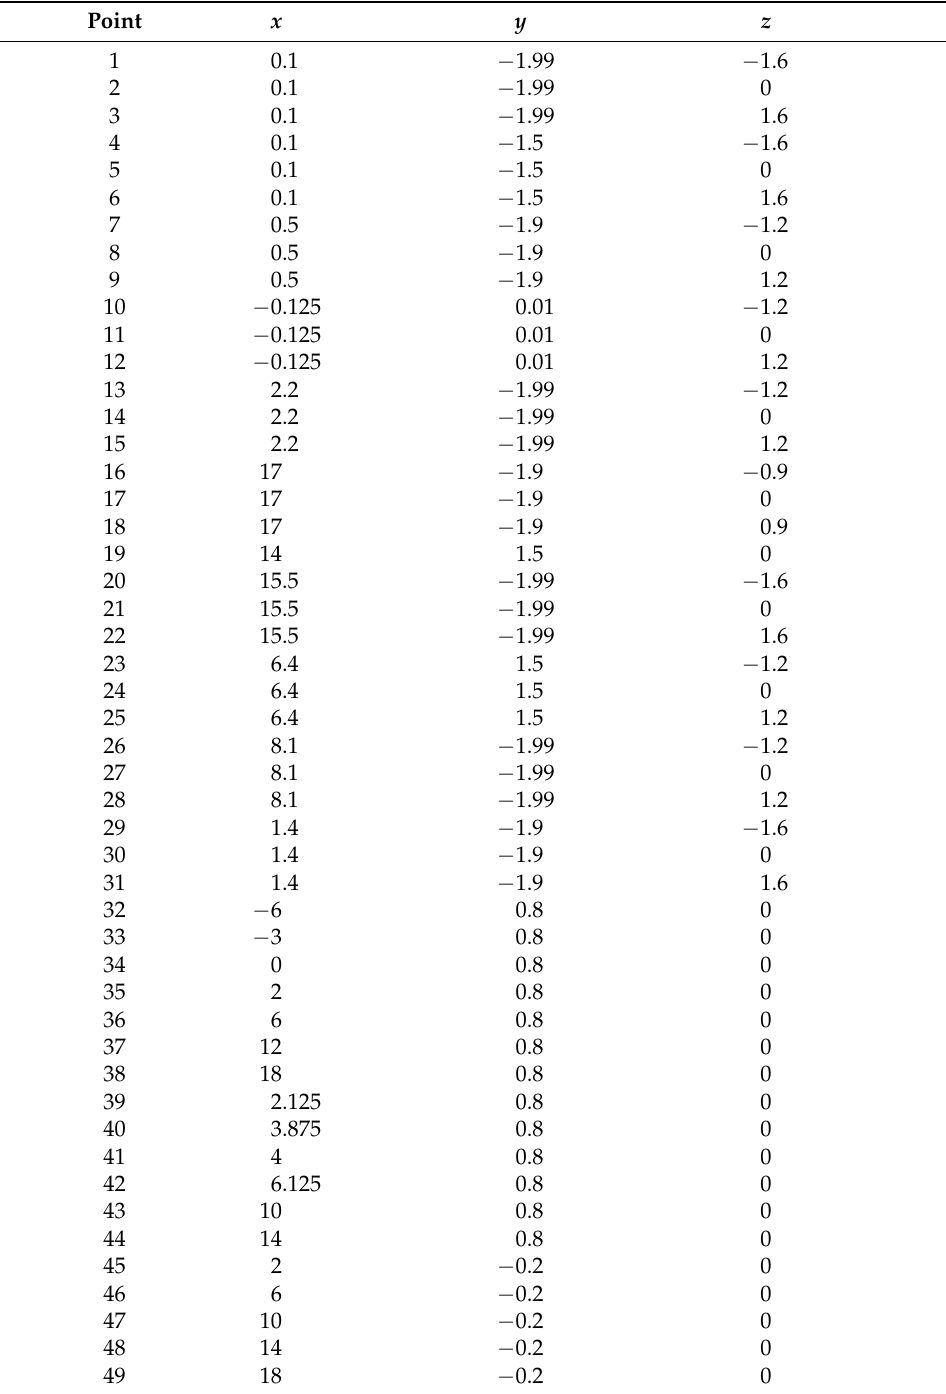
Table A1. Positions of the monitor points throughout the